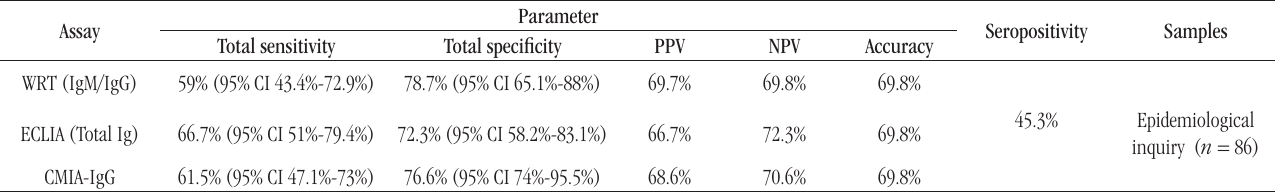
Seropositivity Samples